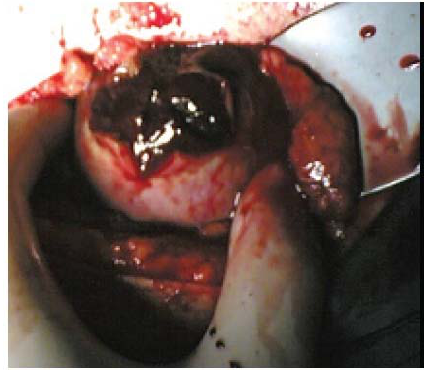
Fig. 2 Hematoma inside the gallbladder.